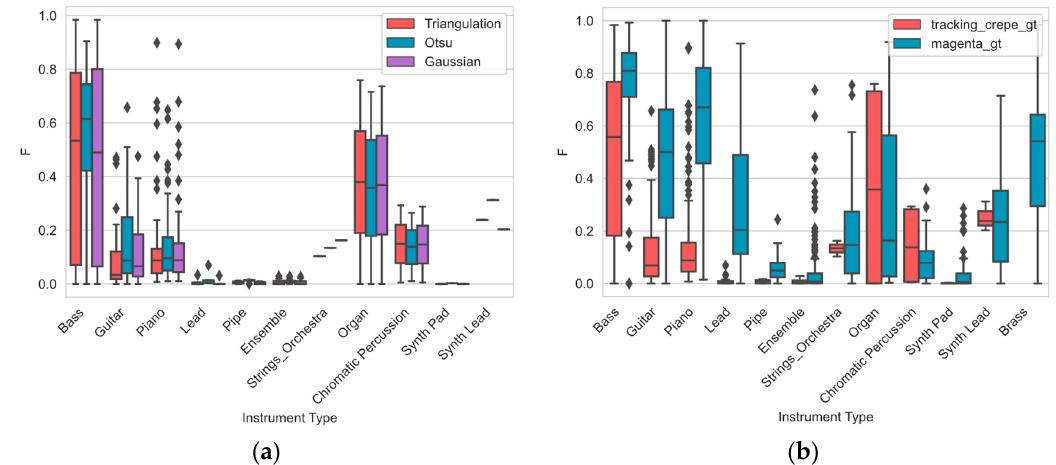
Figure 7. Transcription (note-level) results in terms of F-score for different instrument families in Slakh2100 dataset for: ( a ) Minimum confidence estimation methods and ( b ) CREPE with the note tracking algorithm and Onset and Frames (OaF)